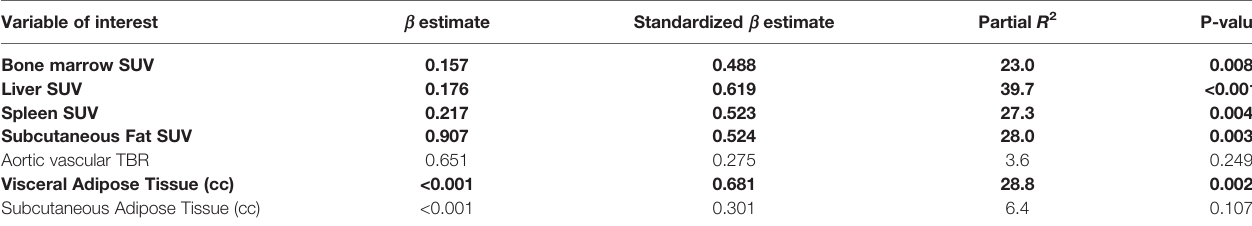
TABLE 2 | Regression analysis of systemic in fl ammation and fat variables with NCB in biologic-naïve subjects with PsA (n = 34), adjusted for Framingham Risk Score. Variable of